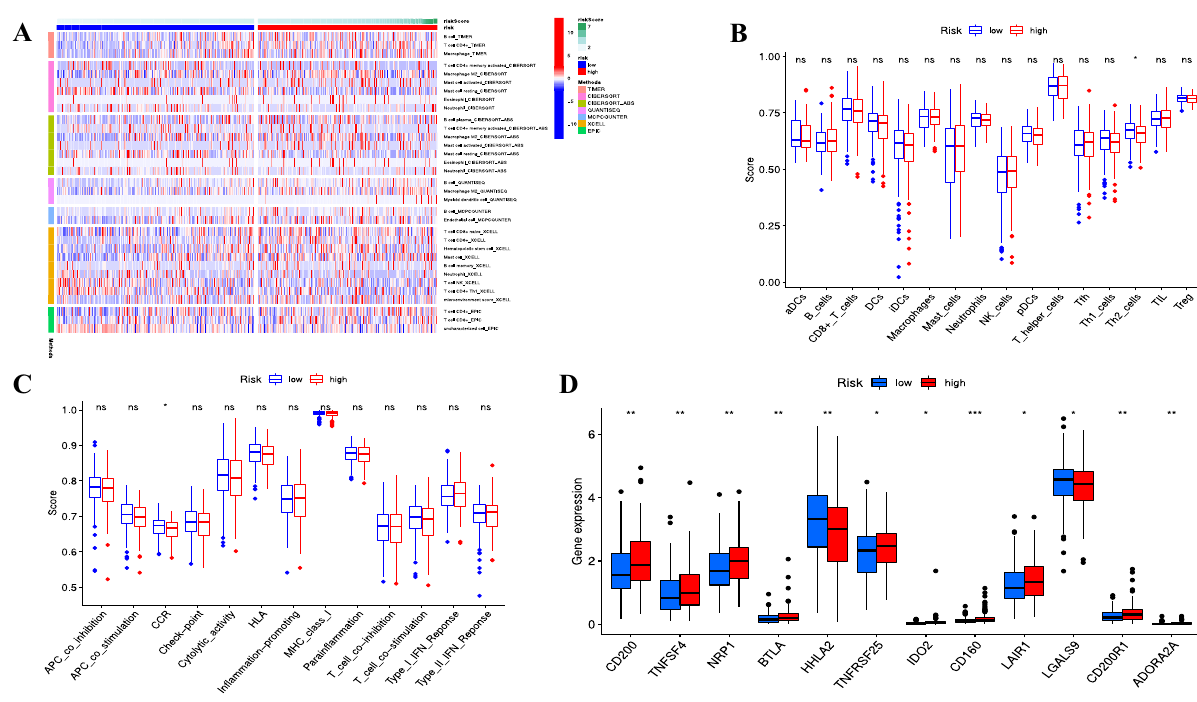
Figure 11. Immune correlation analysis based on CRL signature between high- and low-risk groups. ( A ) Analysis of immune cell infiltration with significant difference in different risk groups. ( B ) The differences in the scores of immune cells in different risk groups. ( C ) The differences in the scores of immune functions in different risk groups. ( D ) The differential expression of immune checkpoints in different risk groups. * p < 0.05, ** p < 0.01, and *** p <